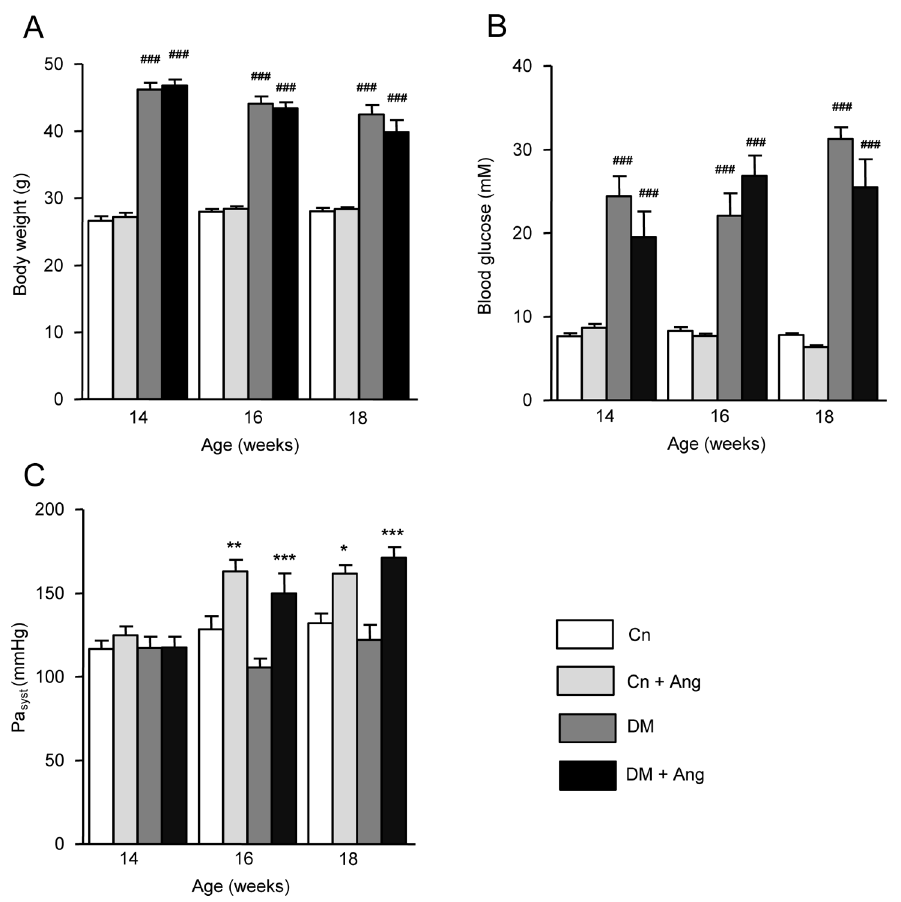
Figure 1. Effect of AngII treatment on blood pressure in non-diabetic and diabetic mice. Body weight (A), blood glucose levels (B) and systolic arterial blood pressure (Pa syst ; C) of non-diabetic (Cn) and diabetic (DM) mice treated with vehicle or AngII (Ang) just prior to treatment (age 14 weeks) and at age 16 and 18 weeks. Data are analyzed by one-way ANOVA with Bonferroni post-hoc testing and expressed as mean 6 SEM (n = 7– 11 per group). * refers to effect of AngII in non-diabetic and diabetic mice (* P , 0.05, ** P , 0.01, *** P , 0.001) and # refers to effect of diabetes in vehicle-treated and AngII-treated mice ( # P , 0.05, ## P , 0.01, ### P , 0.001).